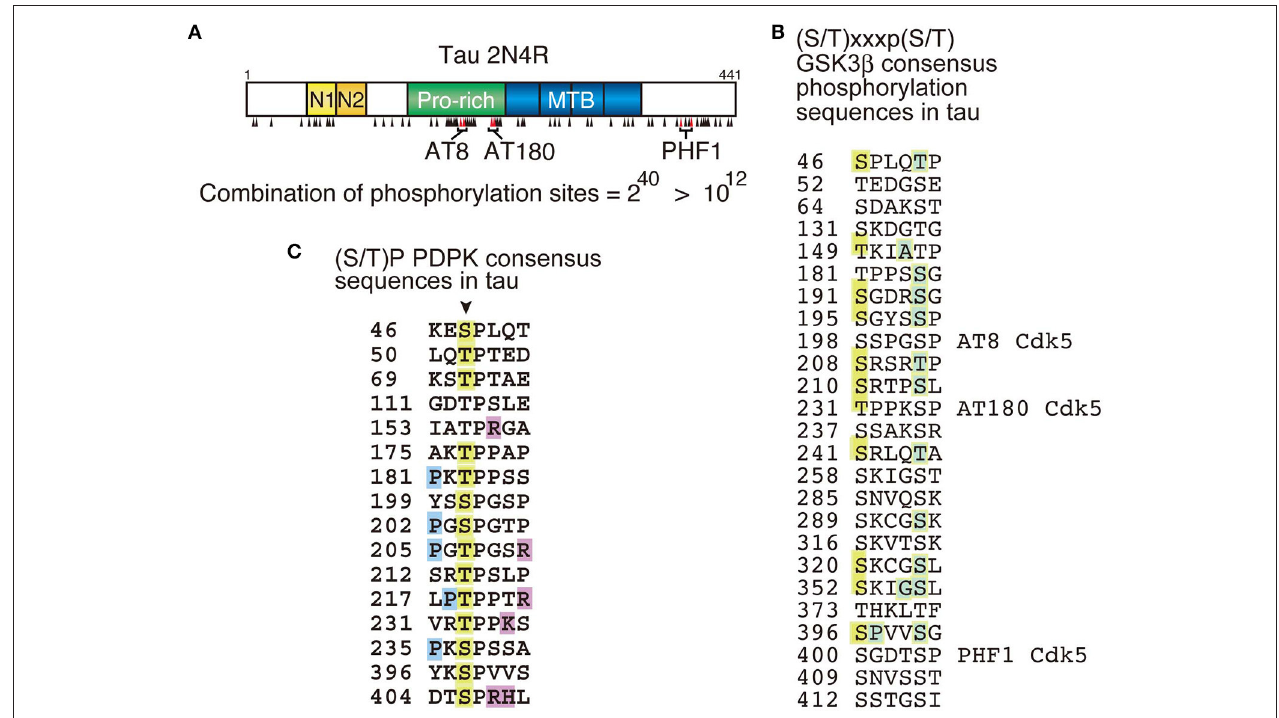
FIGURE 1 | Phosphorylation sites in tau molecule. (A) The longest human tau isoform is composed of 441 amino acids with four microtubule-binding (MTB) repeats in the C-terminal half. Phosphorylation sites are indicated by black arrowheads. AT8 (Ser202 and Thr205), AT180 (Thr231 and Ser235) and PHF1 (Ser396 and Ser404) are phosphospecific antibodies frequently used for the postmortem diagnosis of tauopathy and their epitopes are indicated. The number of phosphorylation combination, if all sites are phosphorylated independently, is indicated below. (B) Amino acid sequences conforming to the GSK3 β consensus sequences, (S/T)xx(x)p(S/T), in tau. There are 25 such sequences and 12 sites are reported to be phosphorylated (orange). The site in the C-terminal sides known to be phosphorylated are indicated by green. (C) Ser/Thr-Pro {(S/T)P} sequences in tau targeted by proline-directed protein kinases (PDPK). Arrow indicates Ser or Thr in (S/T)P sequences. Orange is the reported phosphorylation sites, blue is proline (P) conforming to the consensus sequence {Px(S/T)P or P(S/T)P} for MAPK, and magenta is basic amino acids at the C-terminal site which makes Ser or Thr phosphorylation sites favorable for Cdk5.